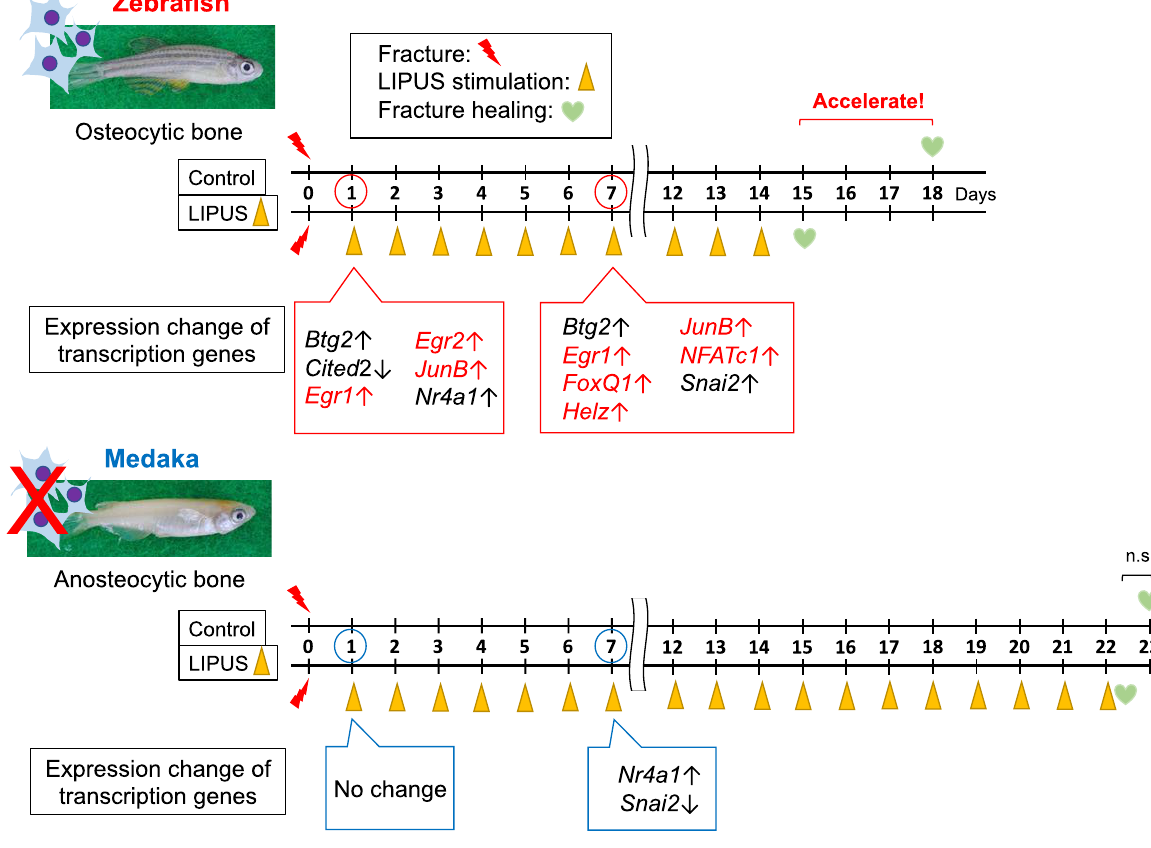
Figure 4. Schematic summary. Schematic representation of the LIPUS effect on the fracture healing and associated transcription factor genes in zebrafish which comprise osteocyte-containing bone and medaka which comprise osteocyte-lacking bone. The photographs of zebrafish and medaka were taken by M.